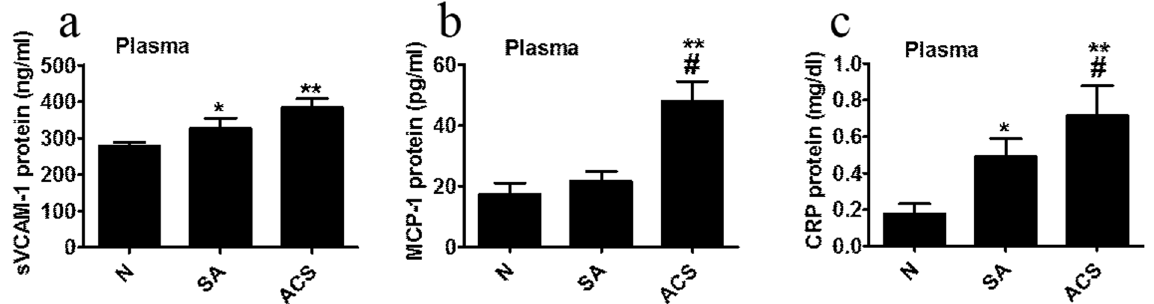
Figure 2. Inflammatory parameters measured in plasma of healthy subjects (N), stable angina patients (SA) and acute coronary syndrome patients (ACS). Levels of soluble vascular cell adhesion molecule 1 (sVCAM-1) ( a ), monocyte chemoattractant protein 1 (MCP-1) ( b ) and C reactive protein (CRP) ( c ). Data are expressed as means ± SEM and analyzed with two-tailed Oneway ANOVA with Least Significant Difference (LSD) Post-hoc test; * p < 0.05, ** p < 0.01 vs. N; # p < 0.05 vs.